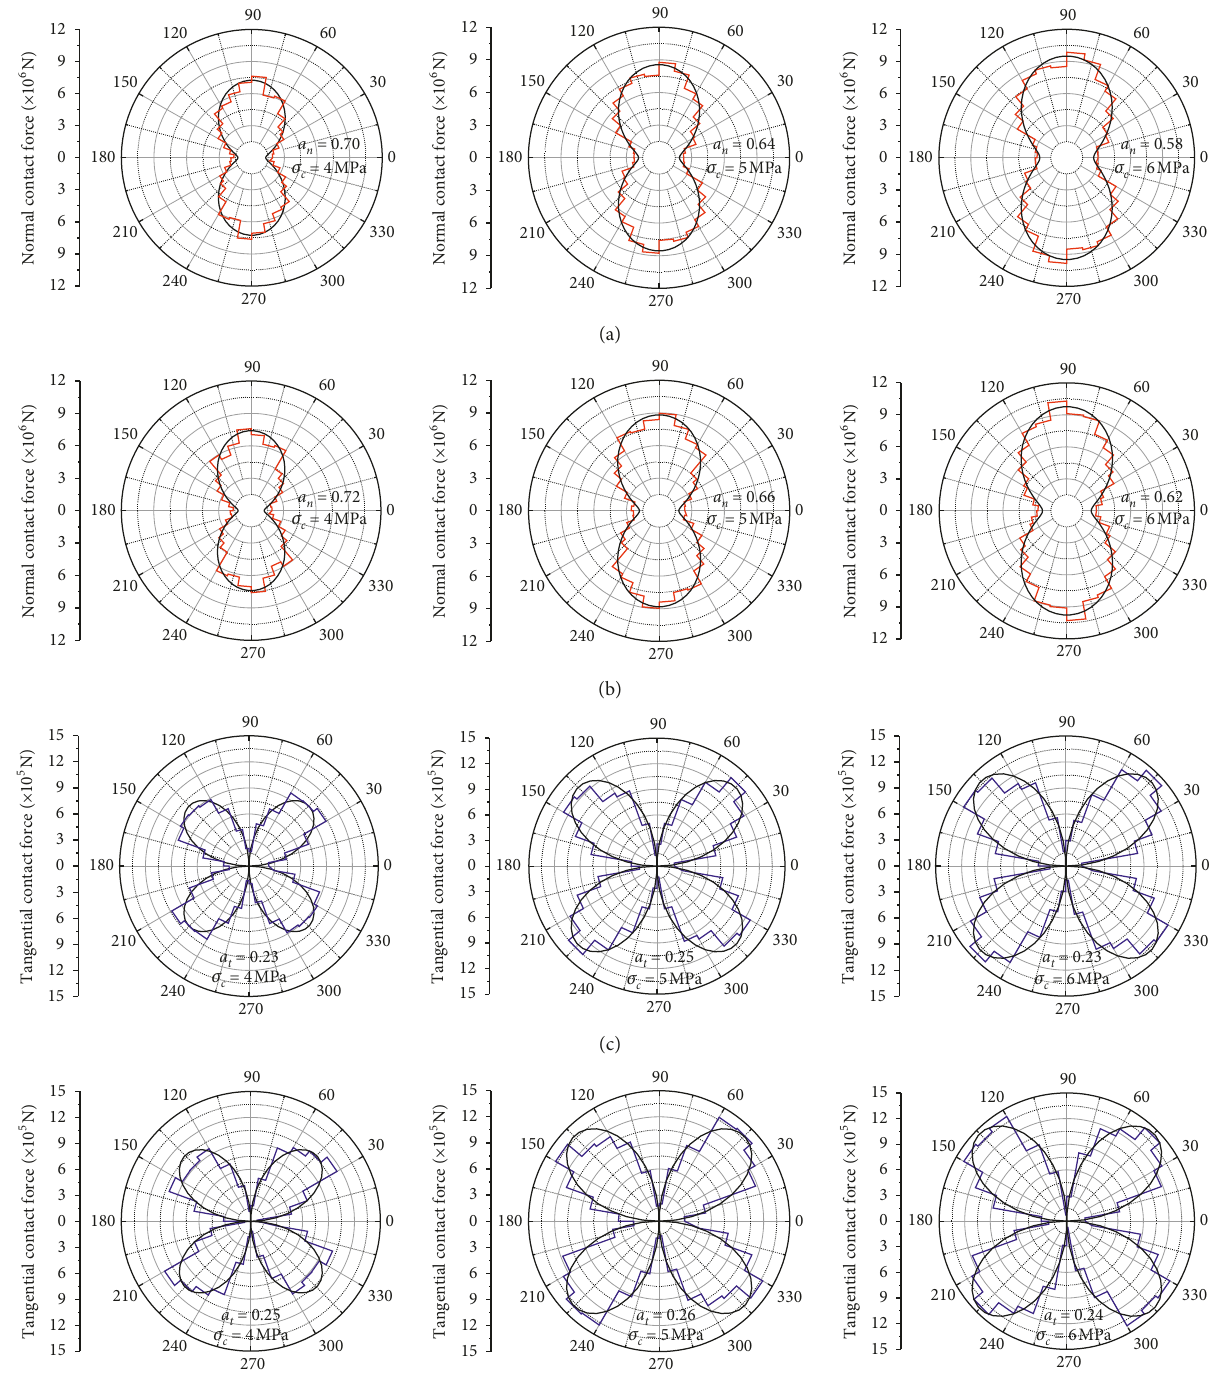
Figure 12: Comparison of anisotropy in breakable and unbreakable samples: (a) normal forces in breakable samples; (b) normal forces in unbreakable samples; (c) tangential forces in breakable samples; (d) tangential forces in unbreakable